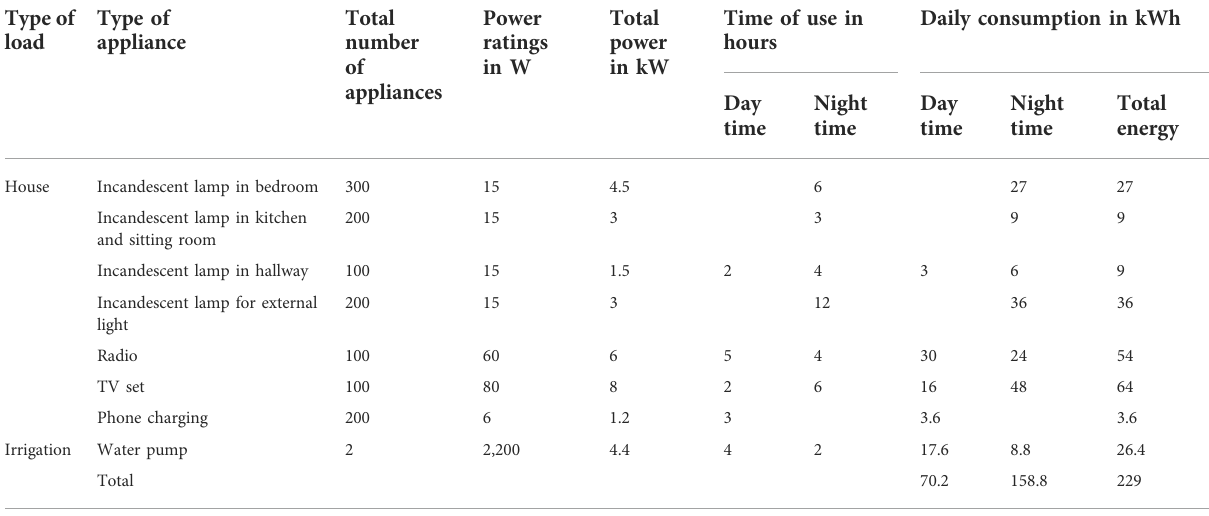
TABLE 2 Daily load estimation and consumption for 100